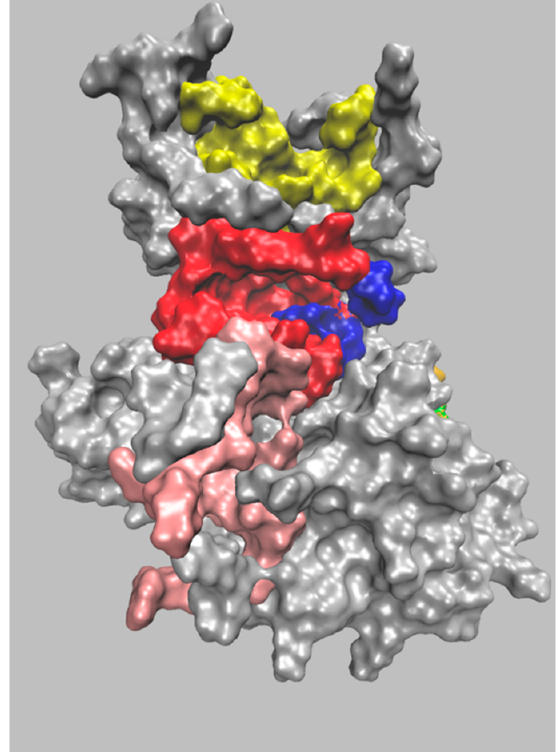
Figure 2. Front view representation of GSK-3 β , with the main pockets found by Pocketron having the same colors as the closest pockets in Palomo et al., 2011 [37] (left panel of Figure 1). Note that the pockets are located in the same regions, although their shapes di ff er.